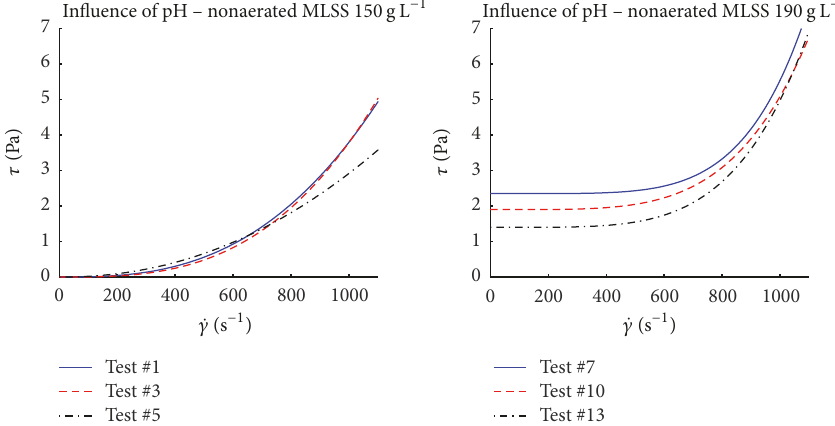
Figure 10: Shear stress versus rate of deformation: influence of pH for nonaerated samples.